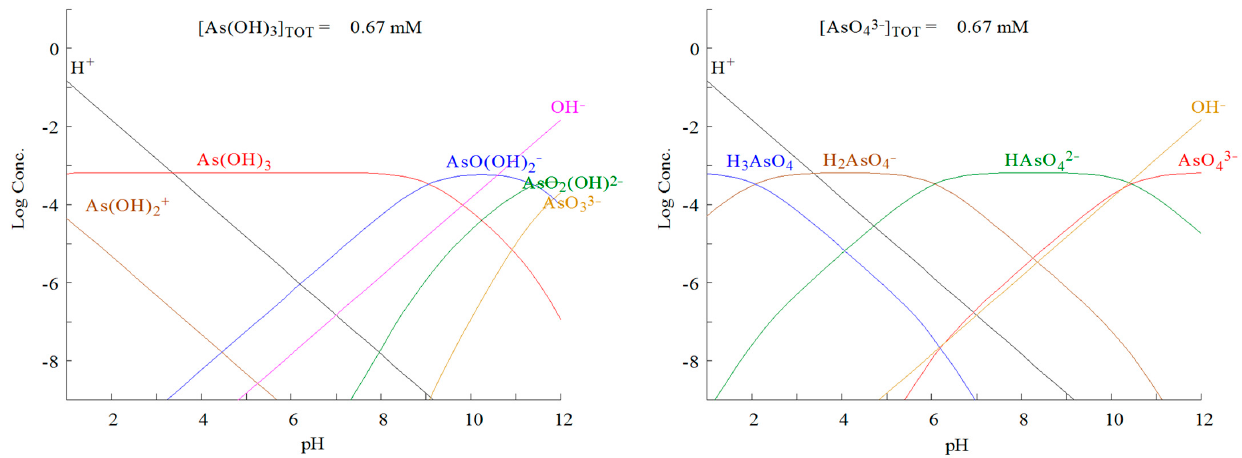
Figure 1. Speciation diagrams for As(III) and As(V) as a function of pH for a total arsenic concentration of 50 mg/L obtained using Hydra and Medusa software (KTH Royal Institute of Technology, Stockholm, Sweden).